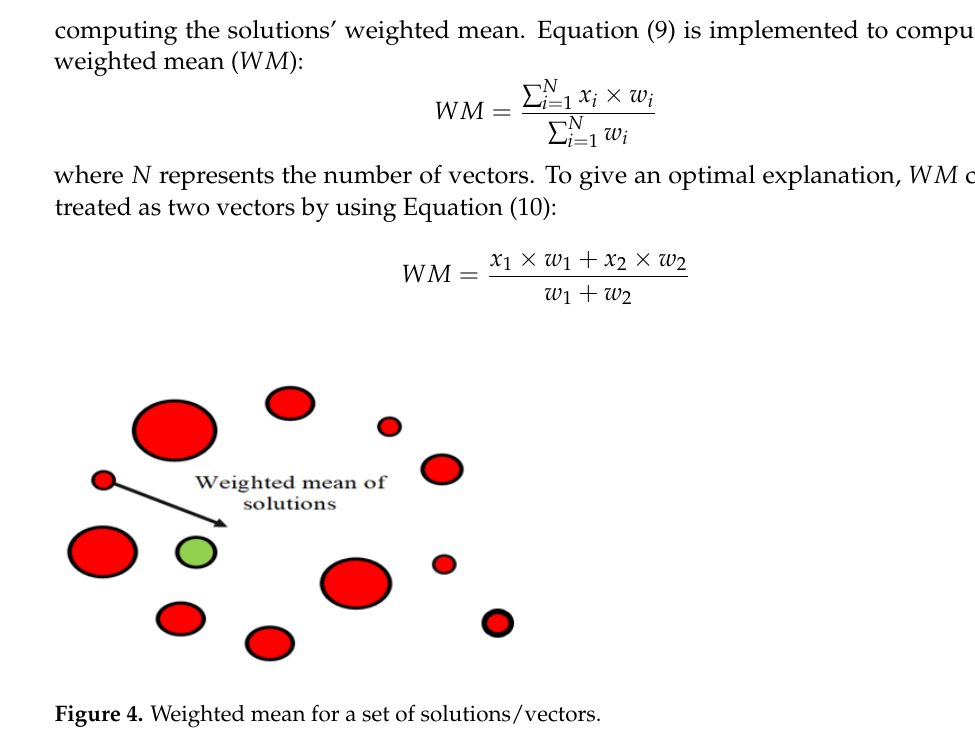
Figure 4. Weighted mean for a set of solutions/vectors.